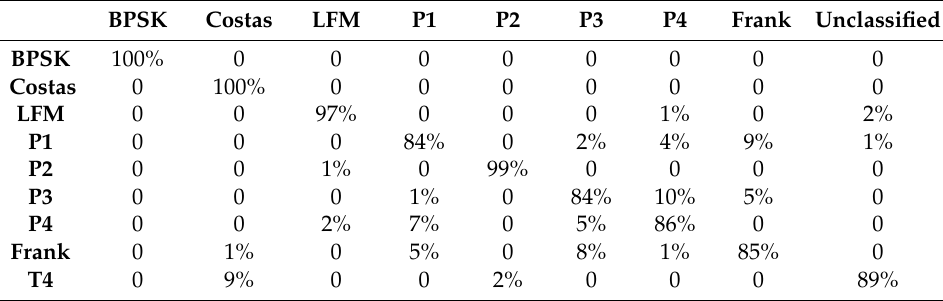
Table 5. Classification results of this paper at SNR = − 4 dB.